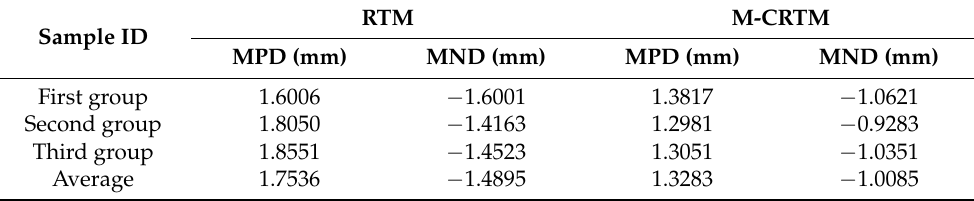
Figure 4. Three-dimensional profile comparison of helmets. ( a ) The helmet manufactured using RTM in the first group; ( b ) the helmet manufactured using M-CRTM in the first group; ( c ) the helmet manufactured using RTM in the second group; ( d ) the helmet manufactured using M-CRTM in the second group, ( e ) the helmet manufactured by RTM in the third group; ( f ) the helmet manufactured by M-CRTM in the third group. Table 1. Statistics of maximum curing deformation of the RTM and M-CRTM